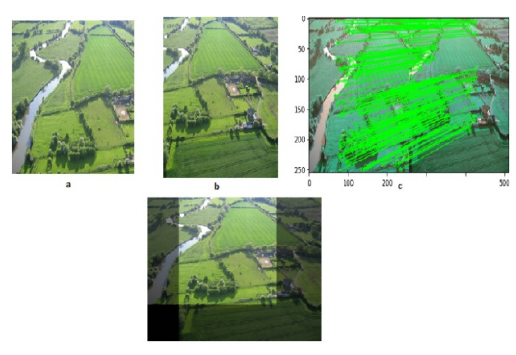
Figure 8. Result -2